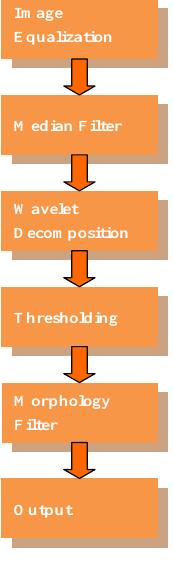
Figure 6. Flow chart of detection